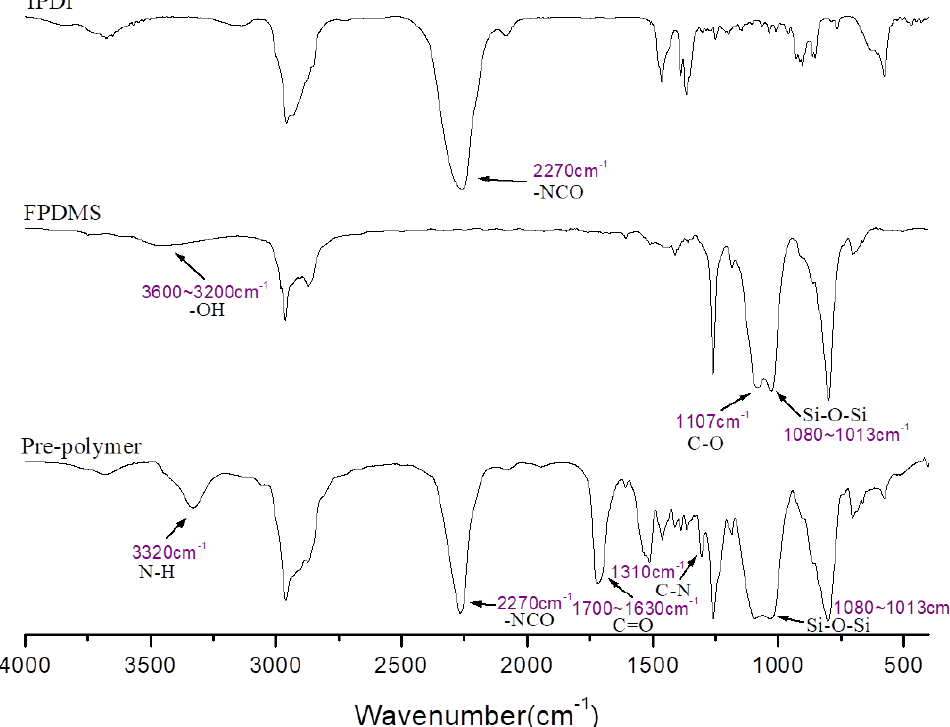
Figure 2. FTIR spectra of IPDI, FPDMS and prepolymer.